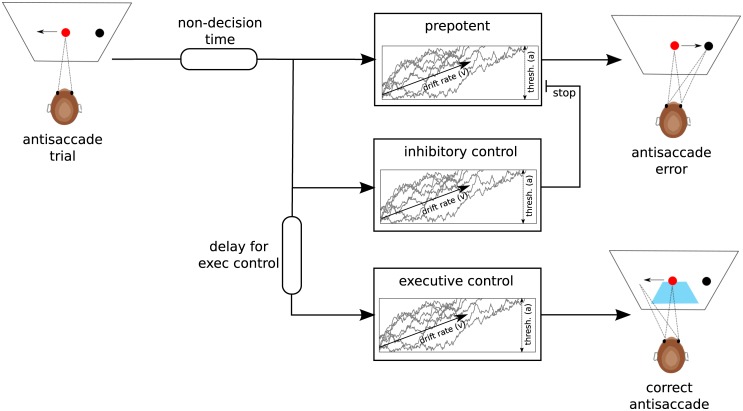
Computational process model of the antisaccade task.The architecture of accumulators during an antisaccade trial is depicted. During prosaccade trials, only the prepotent process is used. See the main text for a description of the model.